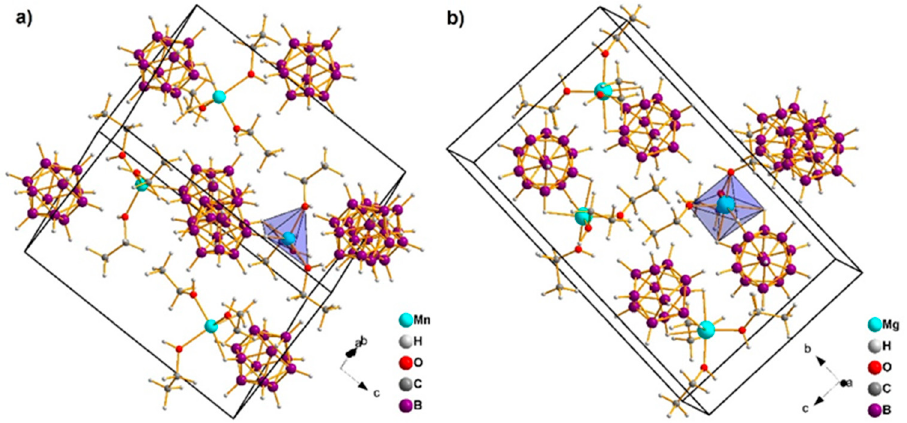
Figure 8 . ( a ) View of the Mn coordination square pyramid inside a triangular bipyramid (B 12 H 12 ) 5 of close to hcp anion packing in m -Mn(EtOH) 3 (B 12 H 12 ). ( b ) View of the Mg coordination octahedron inside a tetrahedron (B 12 H 12 ) 4 of close to ccp anion packing in m -Mg(EtOH) 3 (B 12 H 12 ). Both structures optimized by DFT.